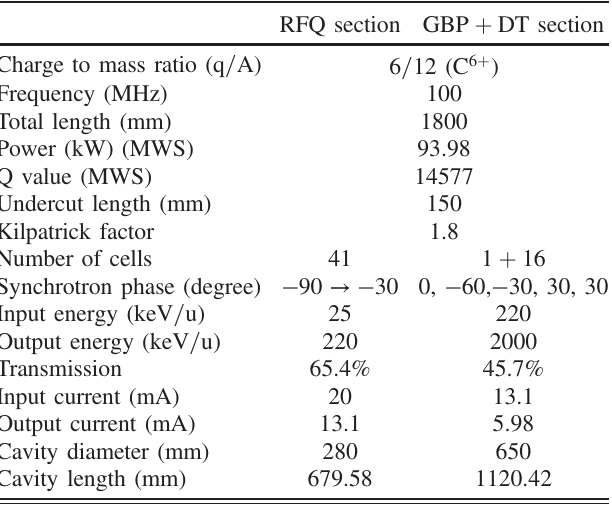
TABLE I. Final design parameters for the HSC linac. RFQ section GBP þ DT